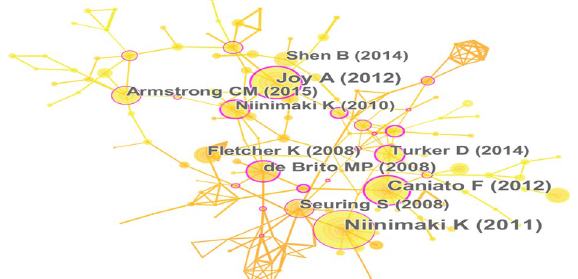
Fig. 2 Document co-citation network for the sustainable development of the textile and apparel industry